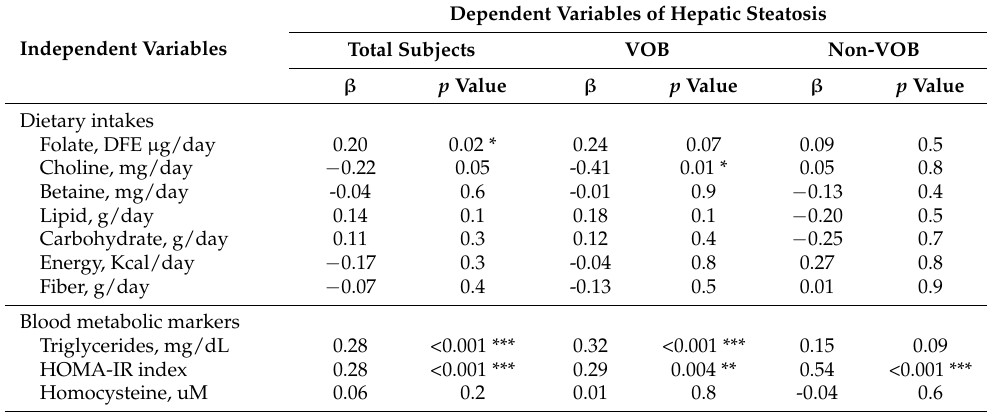
Table 2. Potential dietary and blood determinants of HS in the total and VOB-stratified participants 1,2 .